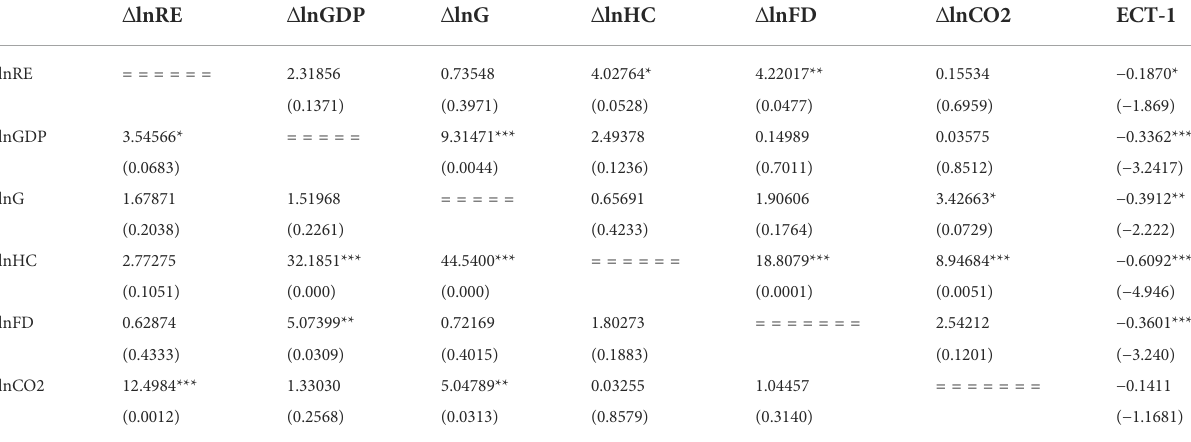
TABLE 9 VECM granger causality